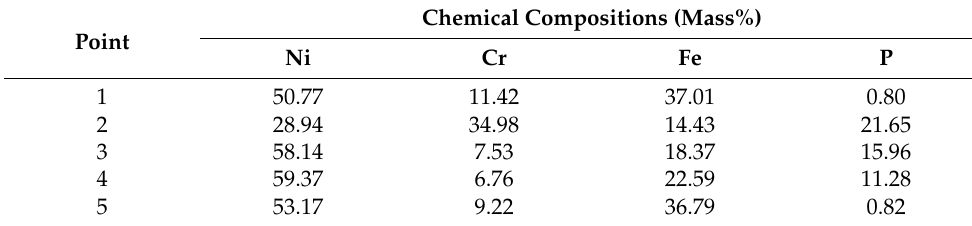
Table 3. Chemical compositions of each phase shown in BSE image in Figure 6.